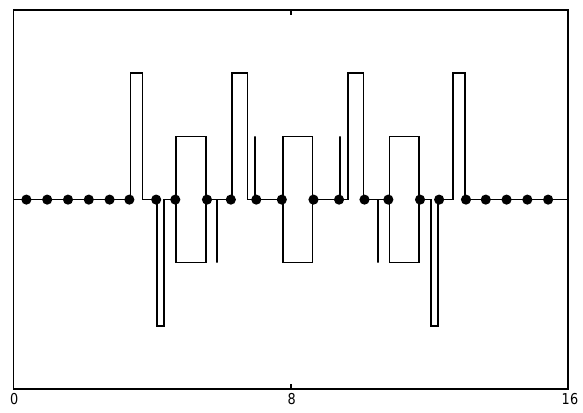
FIG. 5. Layout of a superperiod of the ALS with the additional octupoles. The horizontal axis denotes the length of the refer- ence particle in meters. The rectangles straddling the horizontal axis denote the bends, those above or below the axis are the fo- cussing quads, and the vertical lines denote the sextupoles. The solid dots denote the added